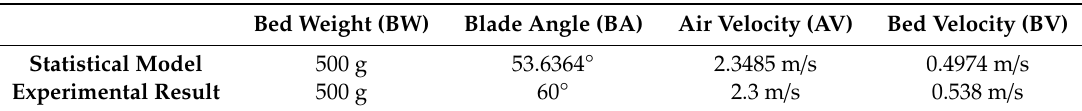
Table 1. The responses of dependent and independent variables predicted through regression analysis of the data.